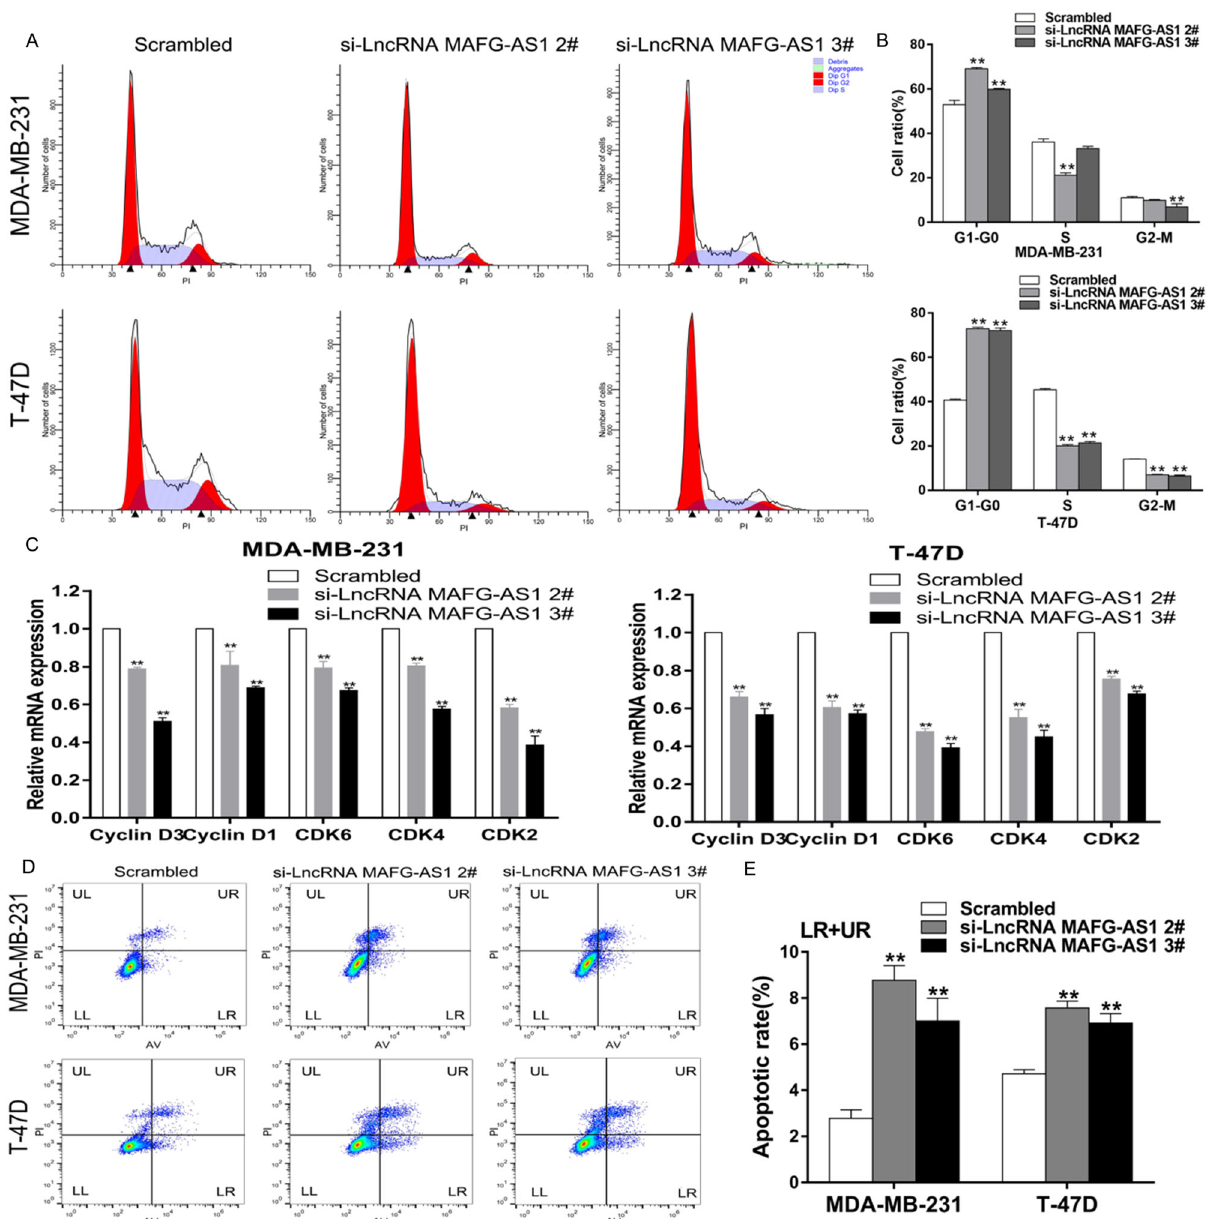
Fig. 3 Inhibition of LncRNA MAFG-AS1 induces G1 arrest and apoptosis in BC cells. MDA-MB-231 and T-47D cells were transfected with si- LncRNA MAFG-AS1 or scrambled. A , B Cell cycle was determined in BC cells. C qRT-PCR analysis of CyclinD3, CyclinD1, CDK6, CDK4, CDK2 in BC cells. D , E Apoptotic rates of cells were tested by fl ow cytometry. Values are shown as the mean ± s.d in three independent experiments. * P < 0.05, ** P < (Fig. 7I). For testing whether STC2 participated in promoting the breast cancer cell proliferation and metastasis mediated by LncRNA MAFG-AS1, rescue experiments were carried out. pcDNA-LncRNA MAFG-AS1 and si-STC2 were co-transfected into MDA-MB-231 and T-47D cells. The results of CCK-8 and Transwell migration assays demonstrated that knockdown of STC2 in MDA- MB-231 and T-47D cells could partially rescue the increased cell proliferating migrating viabilities induced by over-expressing